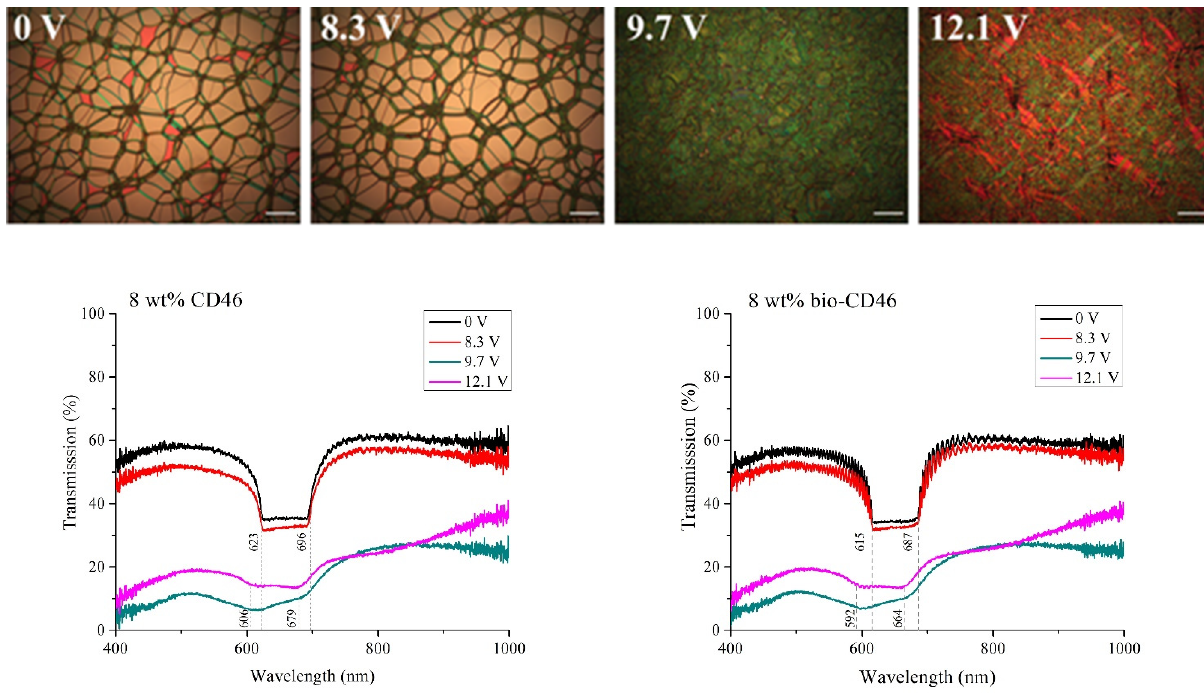
Figure 5. POM image of the texture of 8 wt.% bio-CD46 in E7 host depending on voltage in planar cell with 20 µm gap thickness ( top ). Scale bar equals 100 µm. Transmission spectra depending on voltage for 8 wt.% of CD46 and bio-CD46 in E7 host ( bottom ).